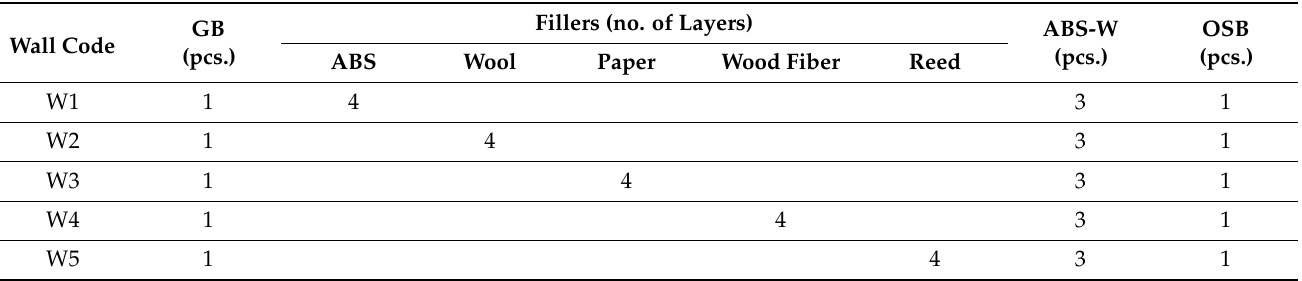
Table 2. Experimental design of the wall structures.